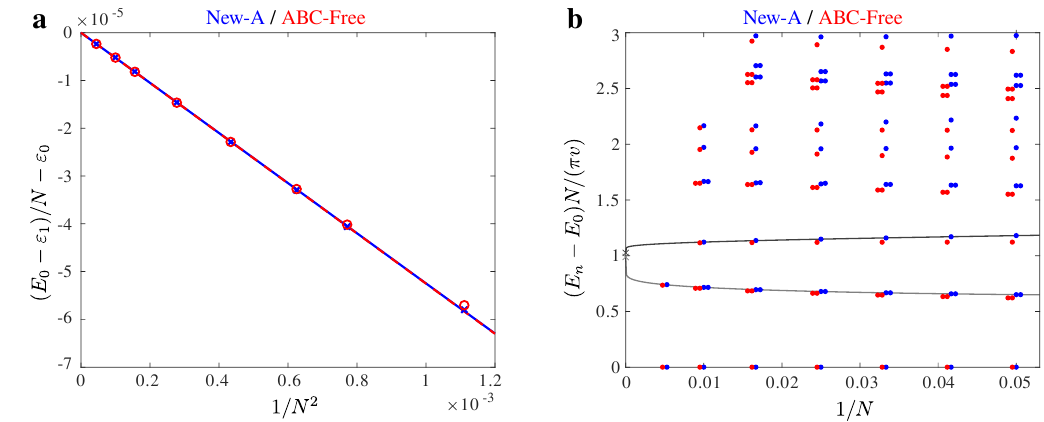
Figure 4: Direct comparison of the conformal tower of states with A-New (blue) and Free-ABC (red) boundary conditions. a Finite-size scaling of the universal part of the ground-state energy, where E is the total energy of a chain with N sites, (cid:34) is an 0 0 energy per site in the thermodynamic limit, (cid:34) is a non-universal contribution from 1 the edges. b Conformal towers of states extracted from the excitation spectra with A- New (blue) and Free-ABC (red) boundary conditions. For clarity some data points are shifted horizontally by up to 2 · 10 − 3 . Black lines are finite-size extrapolation assuming log-corrections in the form derived by Cardy [ 45 ] . Up to some minor finite-site effect the two spectra are identical that implies the duality between the corresponding sets of the boundary